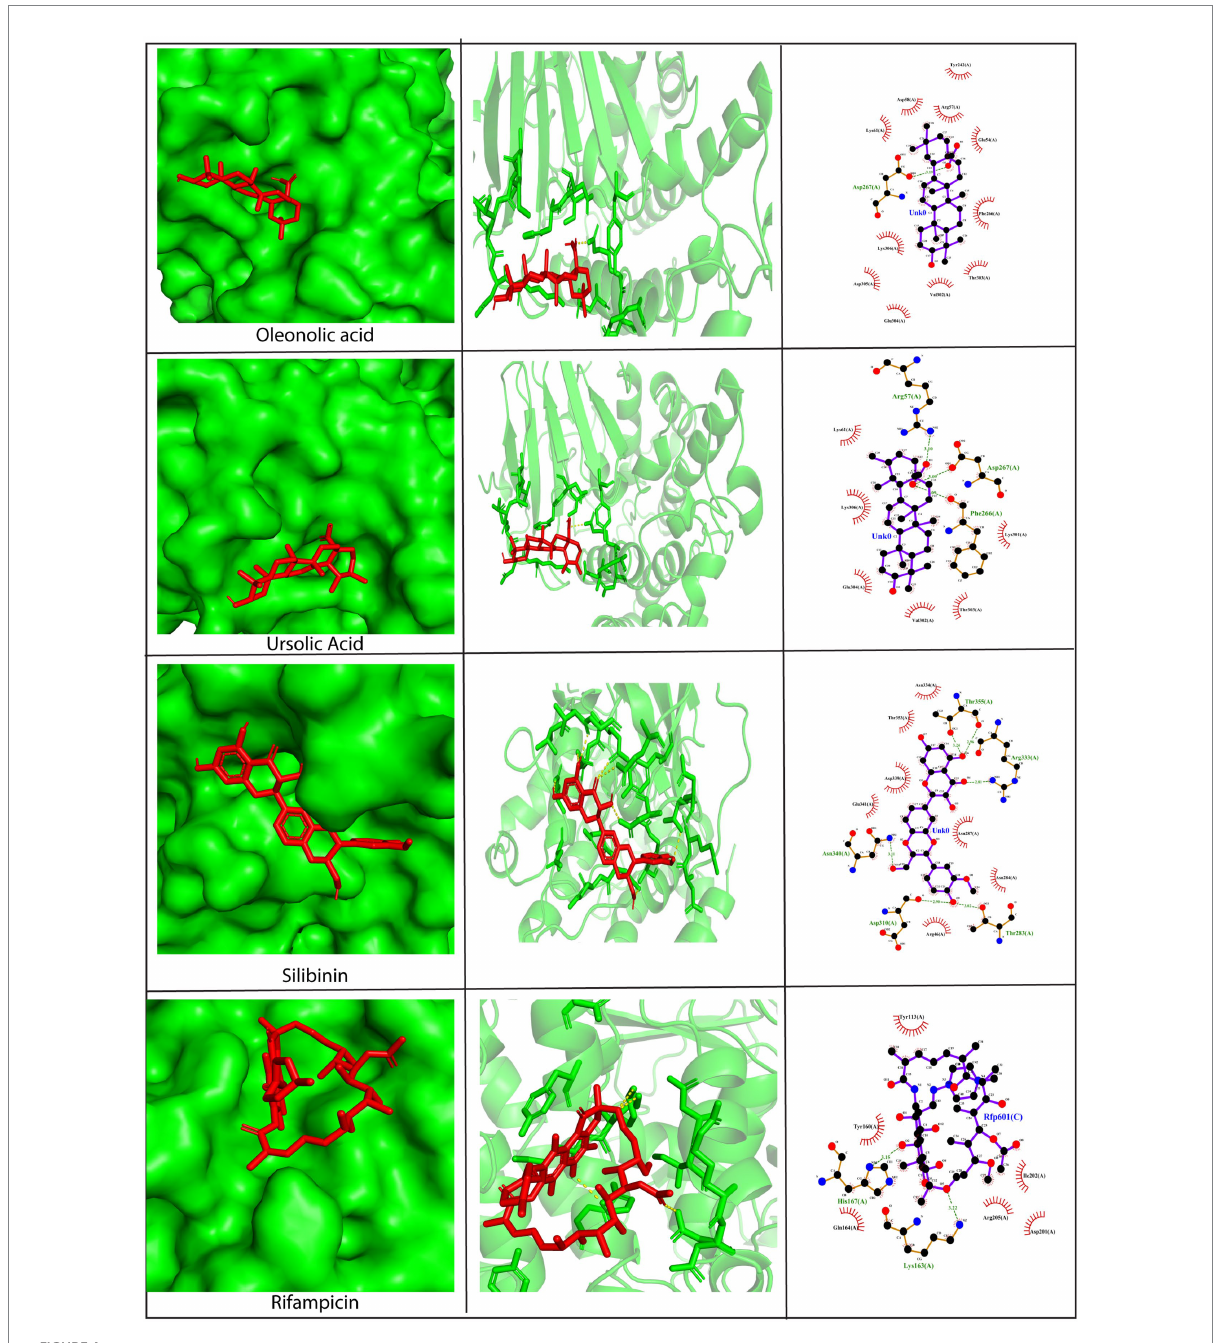
FIGURE 4 Molecular docking of silibinin, oleanolic acid, and ursolic acid against the A26 protein (PDB ID: 6A9S). Left Panel: Visualization of the binding position of the ligand within the protein cavity. Central Panel: Ribbon diagram showing the docked complex. Ligands are shown in red. Right Panel: 2D diagram representing the interactions between phytochemicals and A26 protein generated by LigPlot. Dashed lines depict hydrogen bonds and the red arcs represent hydrophobic interactions. Rifampicin has been used as a control. Docking was performed via AutoDock Vina (Version 1.5.7) and the 3D structures were visualized using PyMol